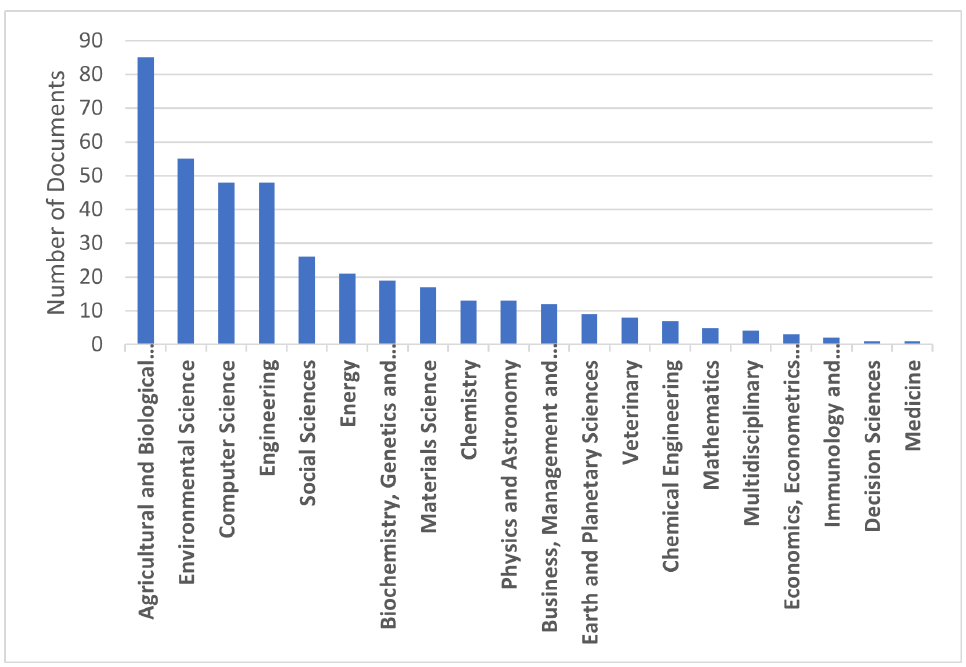
Figure 2. Documents by subject